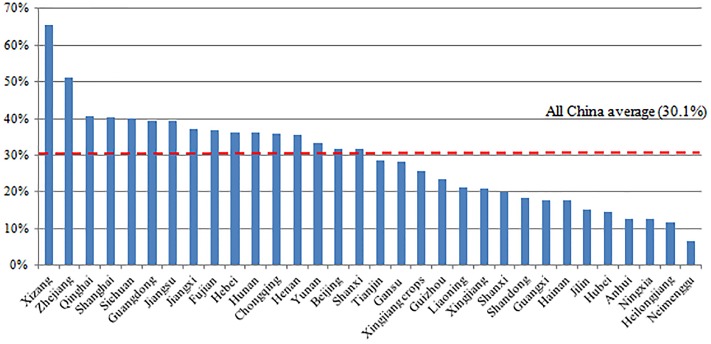
Percentage of left-behind children generated by migrant parent in 32 host provinces.